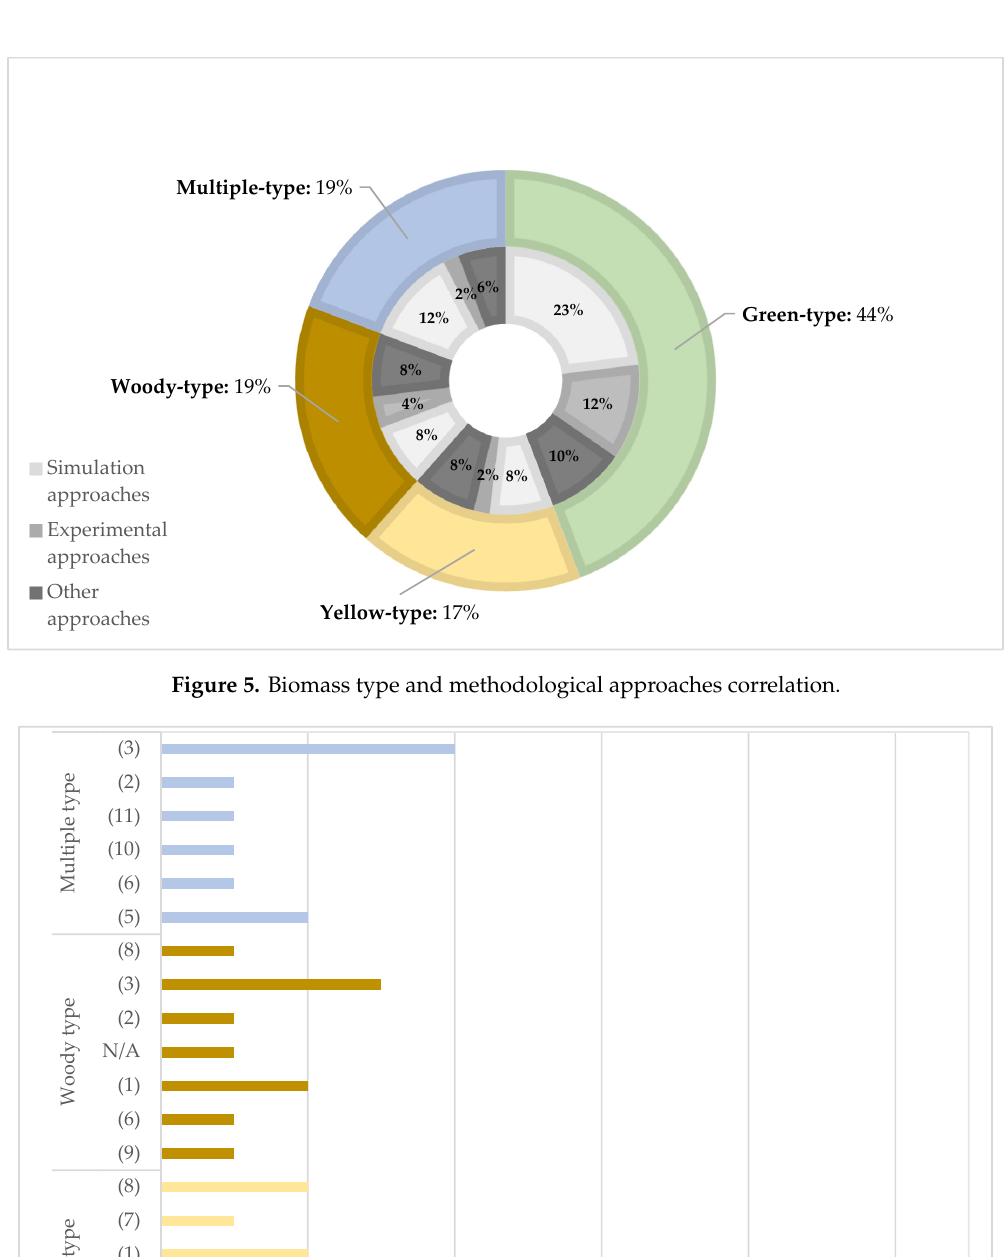
Figure 4. Biomass type in relation to the final product.